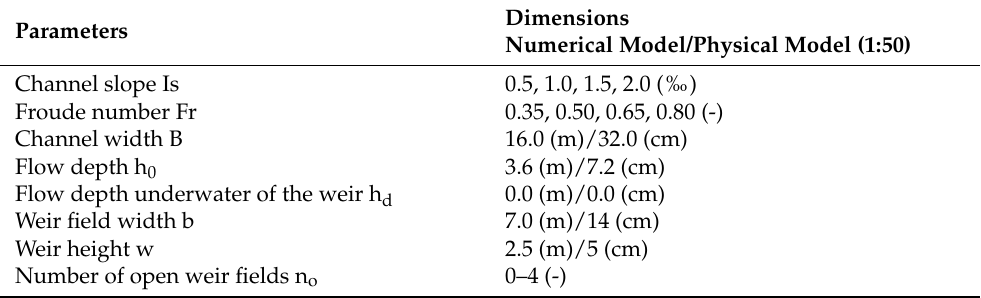
Table 2. Geometric and hydraulic parameters of the physical and the numerical